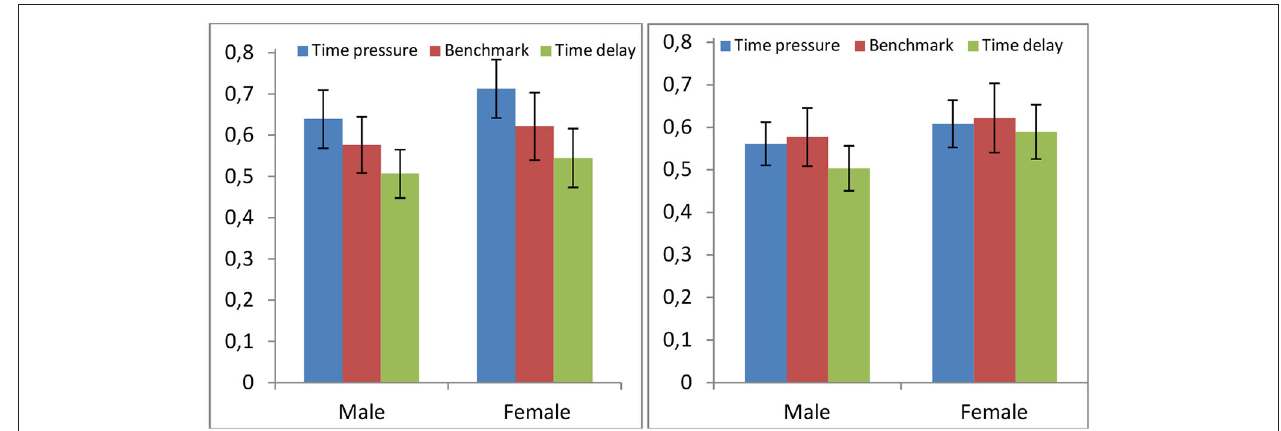
FIGURE 7 | Average contribution in the Public Good Game (PGG) under three differing conditions . Time Pressure , Benchmark (without any time restriction), and Time Delay (Rand et al., 2012). Left: only subjects obeying the time constraint; Right: all subjects.